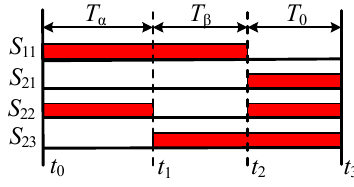
Figure 4. Switching patterns in sector I .